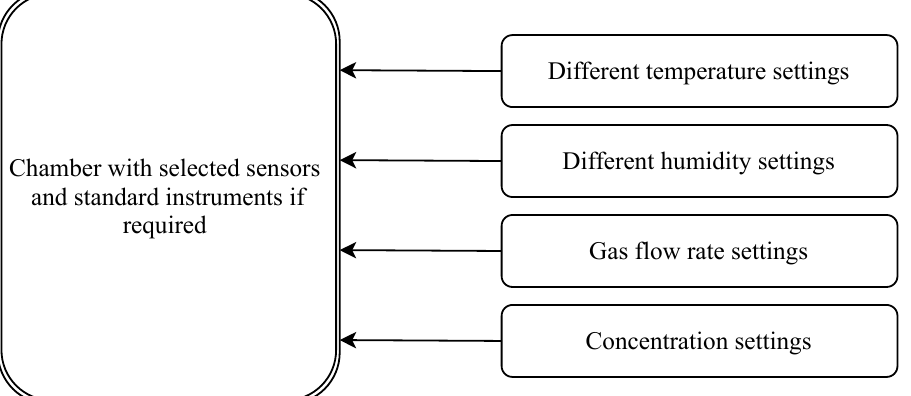
Figure 5. Typical laboratory calibration setup for